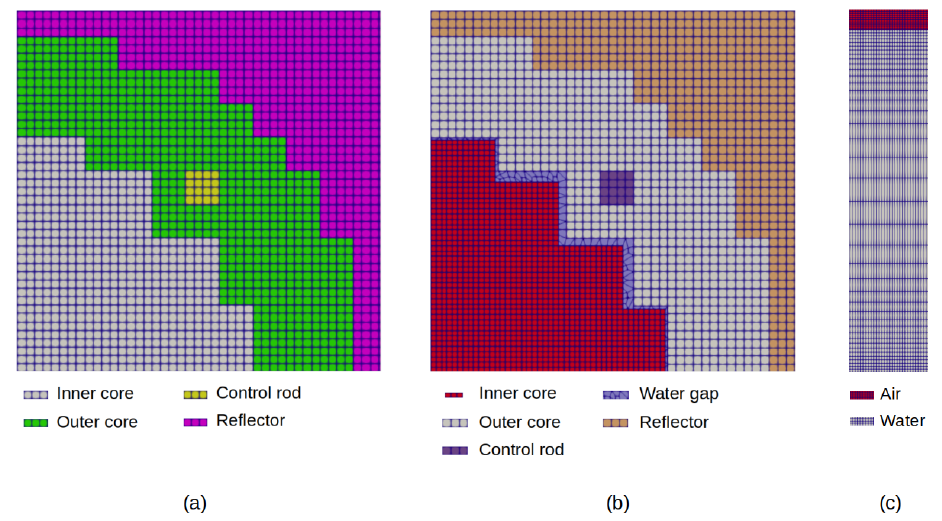
Figure 3. Top view of both the structured ( a ) and the unstructured ( b ) meshes with universe names. Only a reduced quarter of each is displayed to allow for a clear view of the boundaries between re- gions. The axial mesh refinement is also presented in panel ( c